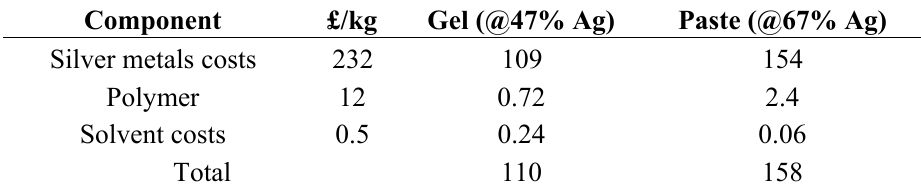
Table 3. Cost analysis for bill of materials for the 47% and 67% silver content for each material